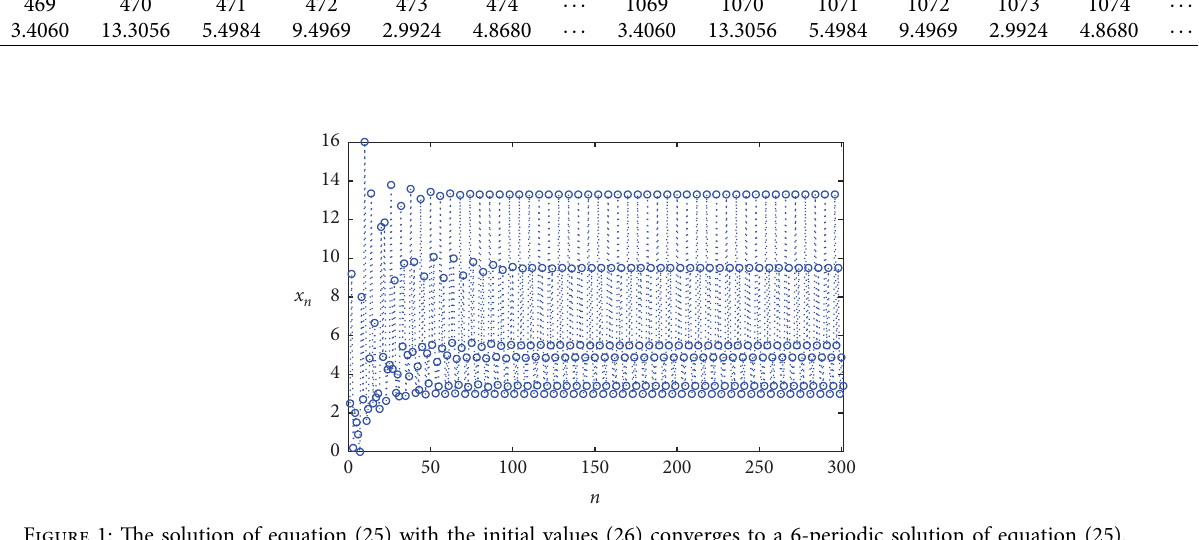
Figure 1: Te solution of equation (25) with the initial values (26) converges to a 6-periodic solution of equation (25).